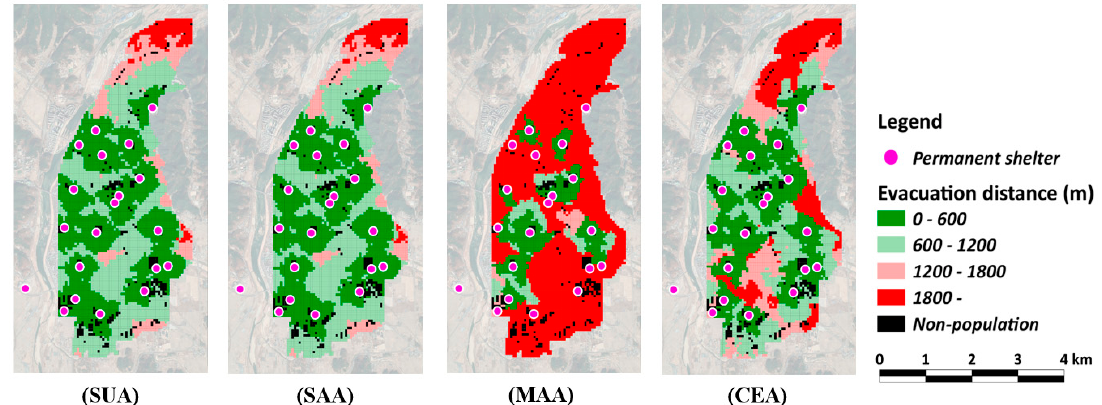
Figure 7. Evacuation distance for each route analysis.